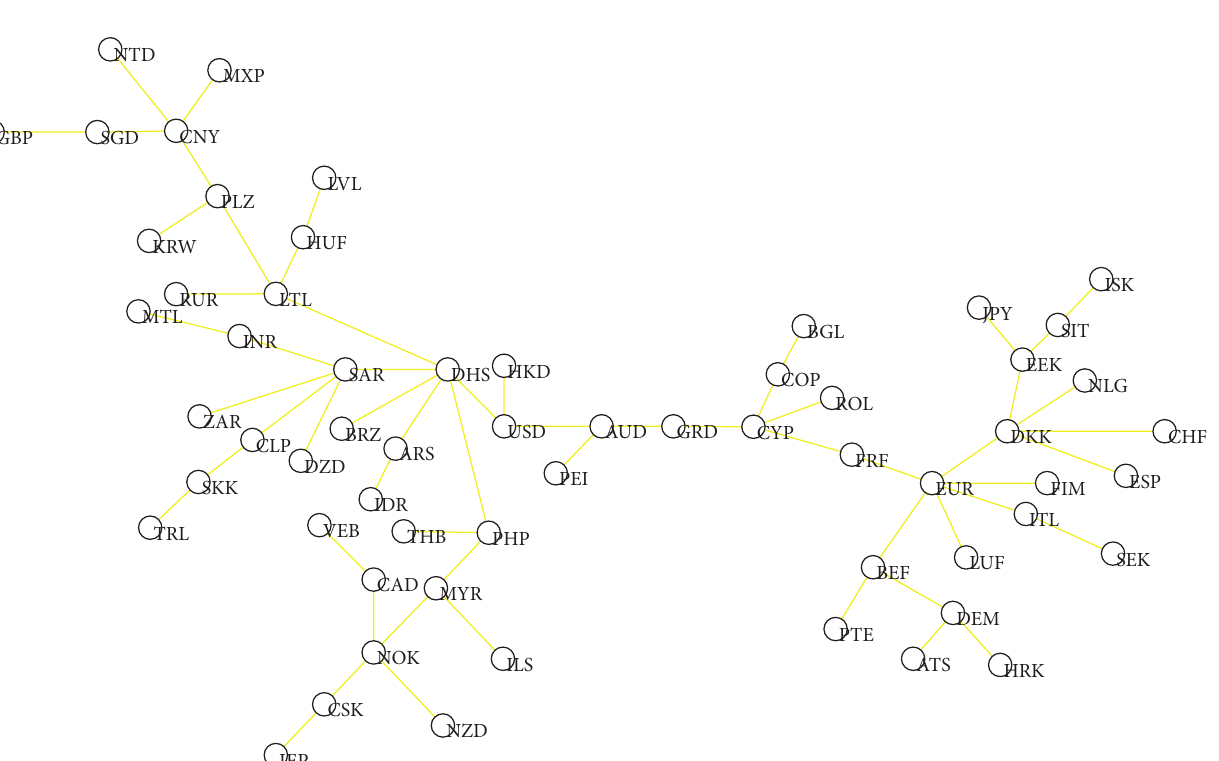
Figure 6: MST of 61 currencies in May 1997, as a representative of the period during Asian financial crises (window length = 12 months).